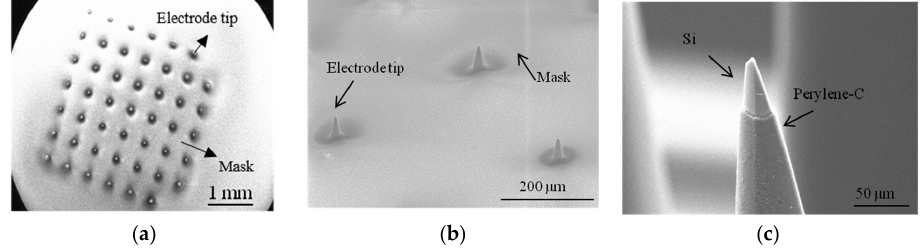
Figure 7. SEM images of masking process: ( a ) electrode array covered with dry-film photoresist after RIE process. Dry-film photoresist follows the 3D structure of the electrodes; ( b ) uniform tip-exposure of variable-height electrodes after RIE and plasma asher etching process; and ( c ) electrode-tip after removing the mask. Table 2. Comparison of conventional and proposed masking processes.